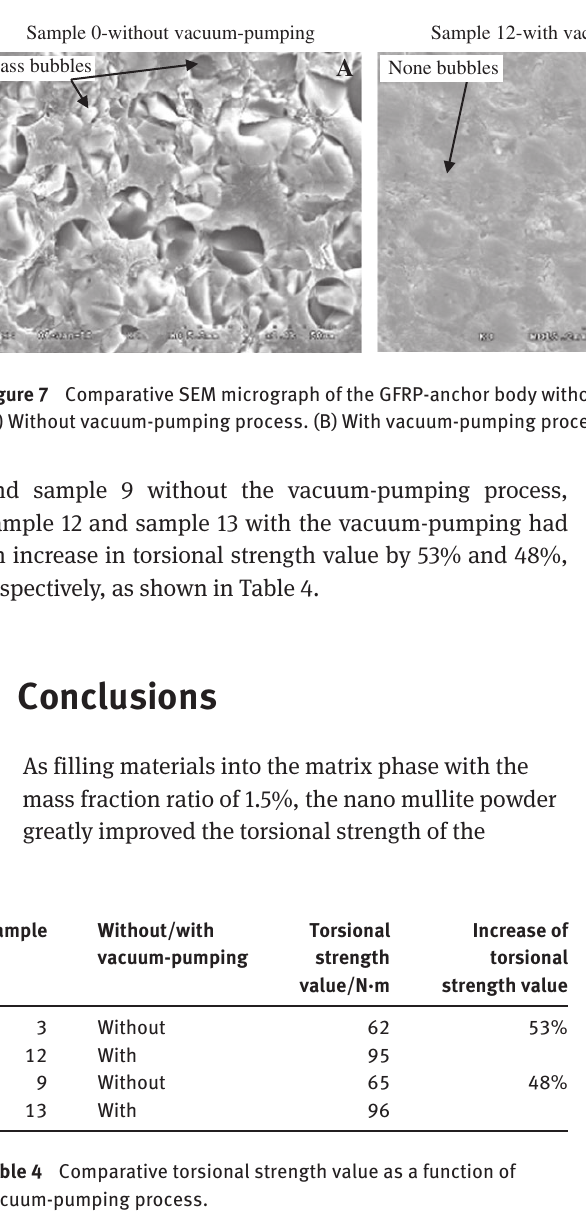
Figure 6 Comparative SEM micrograph of the GFRP-anchor body with different acrylic-polyurethane emulsion contents. (A) None-sample 0. (B) 5% -sample 9.